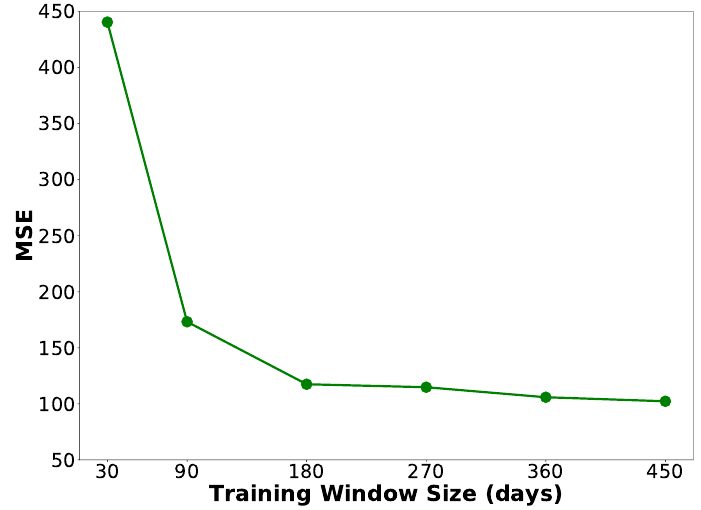
Figure 15. MSE performance of the three-layer ANN model with different training window sizes of {30, 90, 180, 270, 360, 450}